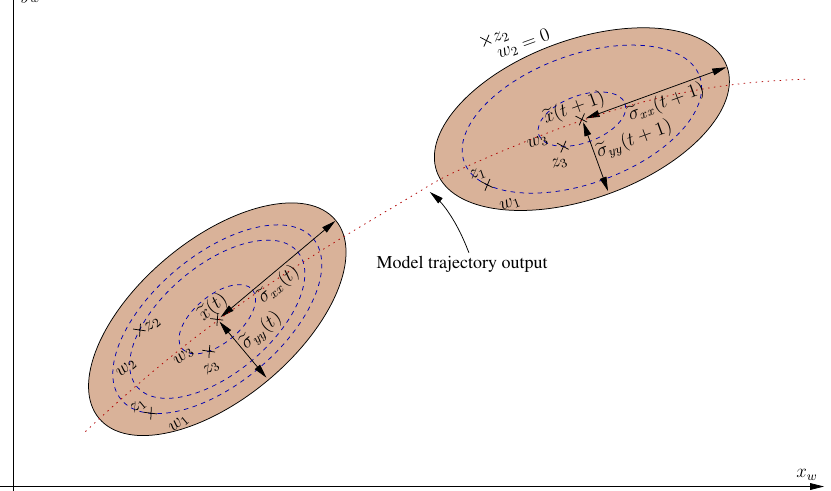
Figure 17. Representation of predicted ellipses of uncertainty and weight allocation to each measure to be applied in